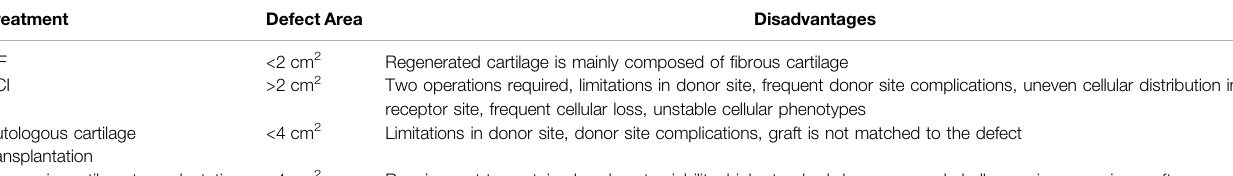
TABLE 1 | Comparison of cartilage defect treatments widely used in clinics.